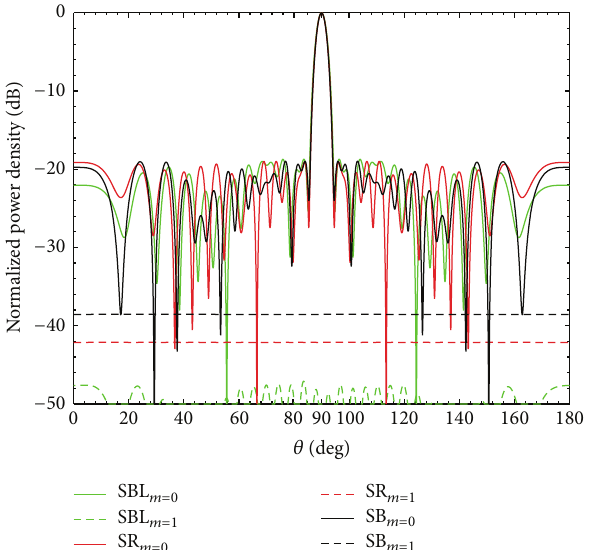
Figure 13: Radiation patterns at carrier frequency and at first harmonicrelatedtoFigure 12forSC—the 𝑚 subscriptrepresentsthe harmonic number.